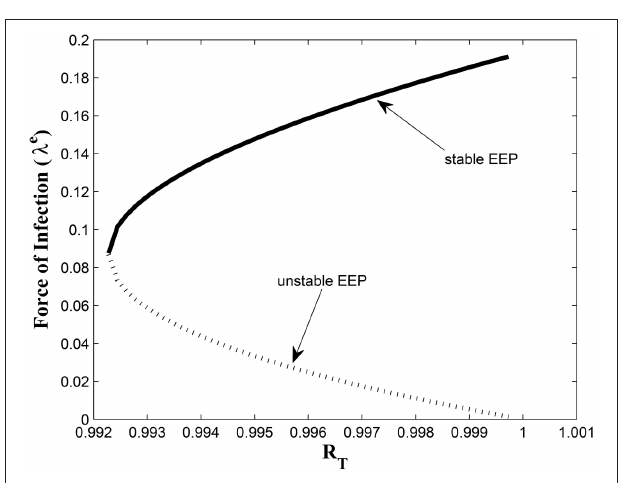
FIGURE 6 | Backward bifurcation when b 1 6= 0 and b 2 = 0